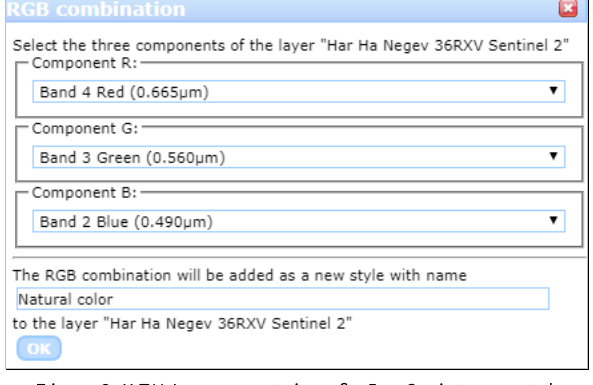
Figure 2. HTML representation of a JavaScript generated window to define new RGB combinations from individual components.